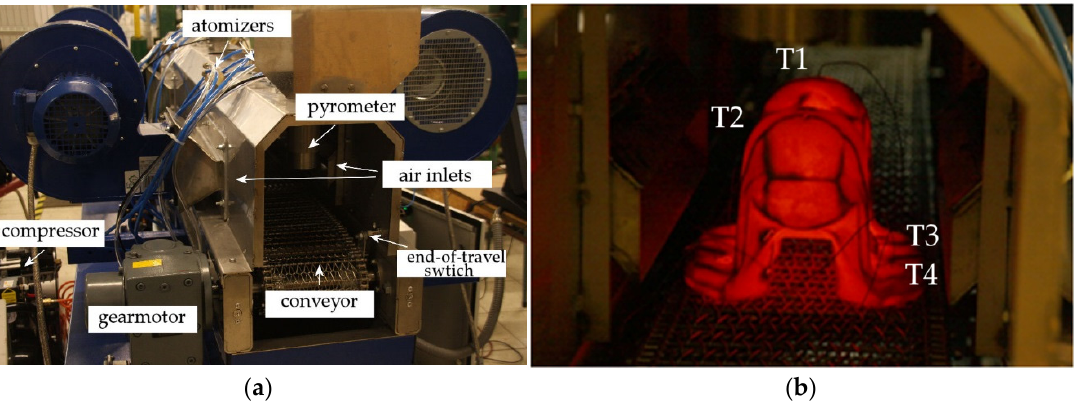
Figure 2. Experimental cooling tests: ( a ) controlled cooling simulator QuenchTube Lab, ( b ) cooling of the forged sample used for the measurements. Table 2. The cooling conditions assumed for the case study cooling tests.